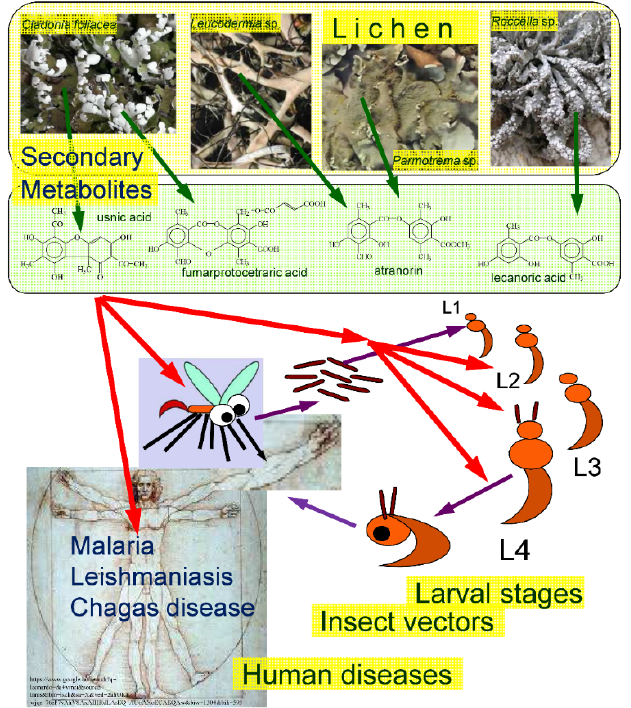
Figure 1. The subject of the survey summarized. Green arrows symbolize the origin of LSMs from various lichens, red arrows represent the effects of LSMs on insect vectors, their various larval developmental stages (L1–L4) and human diseases caused by parasitic protozoa transmitted by insect